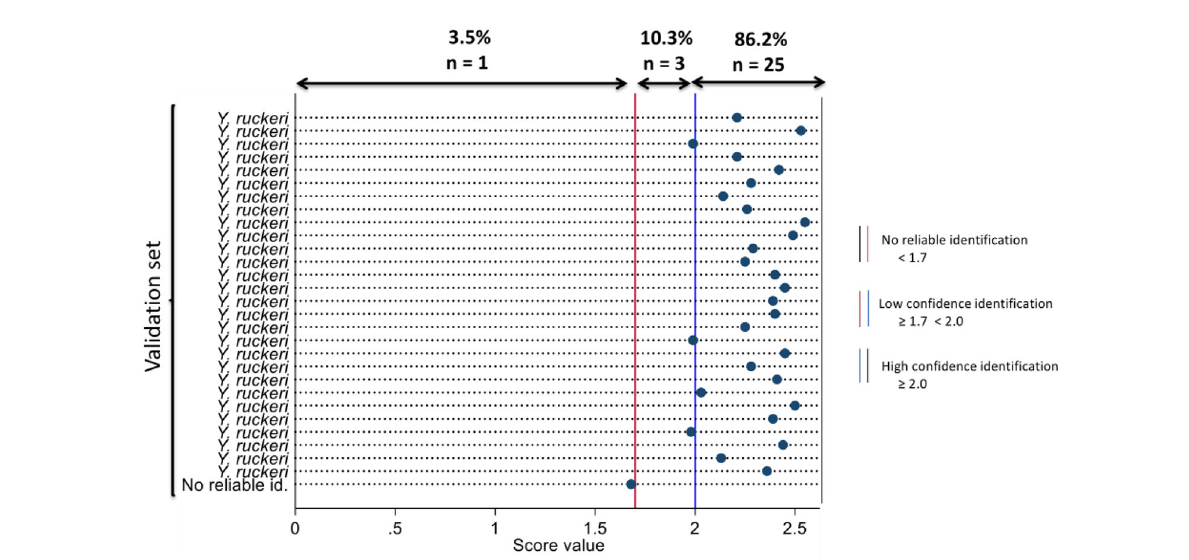
FIGURE1 Dot diagram showing the organism that best matches the isolates in the validation set using the novel main spectral profile and their respective log scores at MALDI-TOF MS identification.